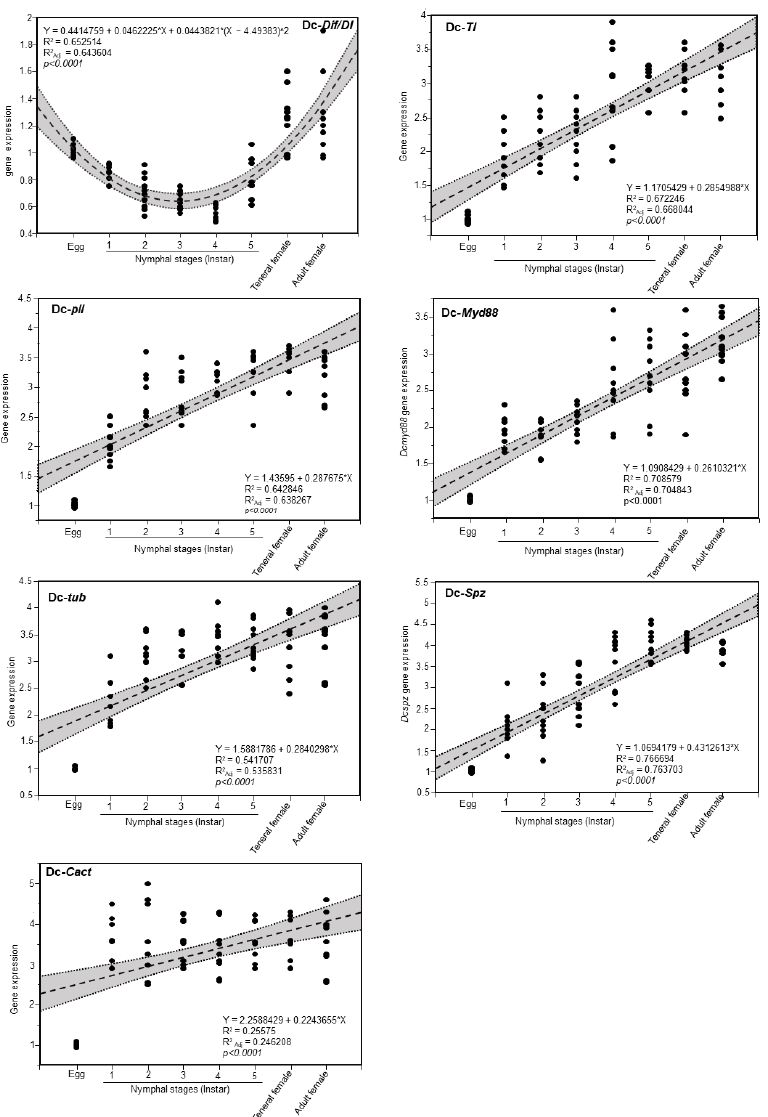
Figure 8. Regression of the relative expression level of genes involved in the Toll pathway in D. citri . Dorsal-related immunity factor/Dorsal (Dif/DI), Pelle (pll), Tube (tub), Cactus (cact), Toll (TI), Myeloid differentiation factor 88 (Myd88), and Spaetzle (spz) genes expression in different developmental stages of D. citri . Quadratic polynomial regression analysis between Dif/DI gene expression and developmental stages of D. citri . Simple linear regression analysis between pll, tub, cact, TI, myd88, spz genes expression and D. citri developmental stages. In the linear and quadratic polynomial regression, dots show the raw data. The black round shapes indicate the raw data ( n = 10). The fitted and polynomial regression line is presented as dashed lines. The 95% confidence interval (CI) for estimated regression is presented as gray-shaded and edged by dotted lines. The regression equation, RSquare (R 2 ) and Rsquare Adj (R 2 adj), and p -value obtained after F tests are presented within each